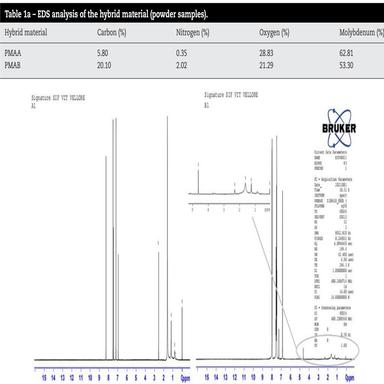
NMR spectra of PMA, PMAA and PMAB hybrid materials.